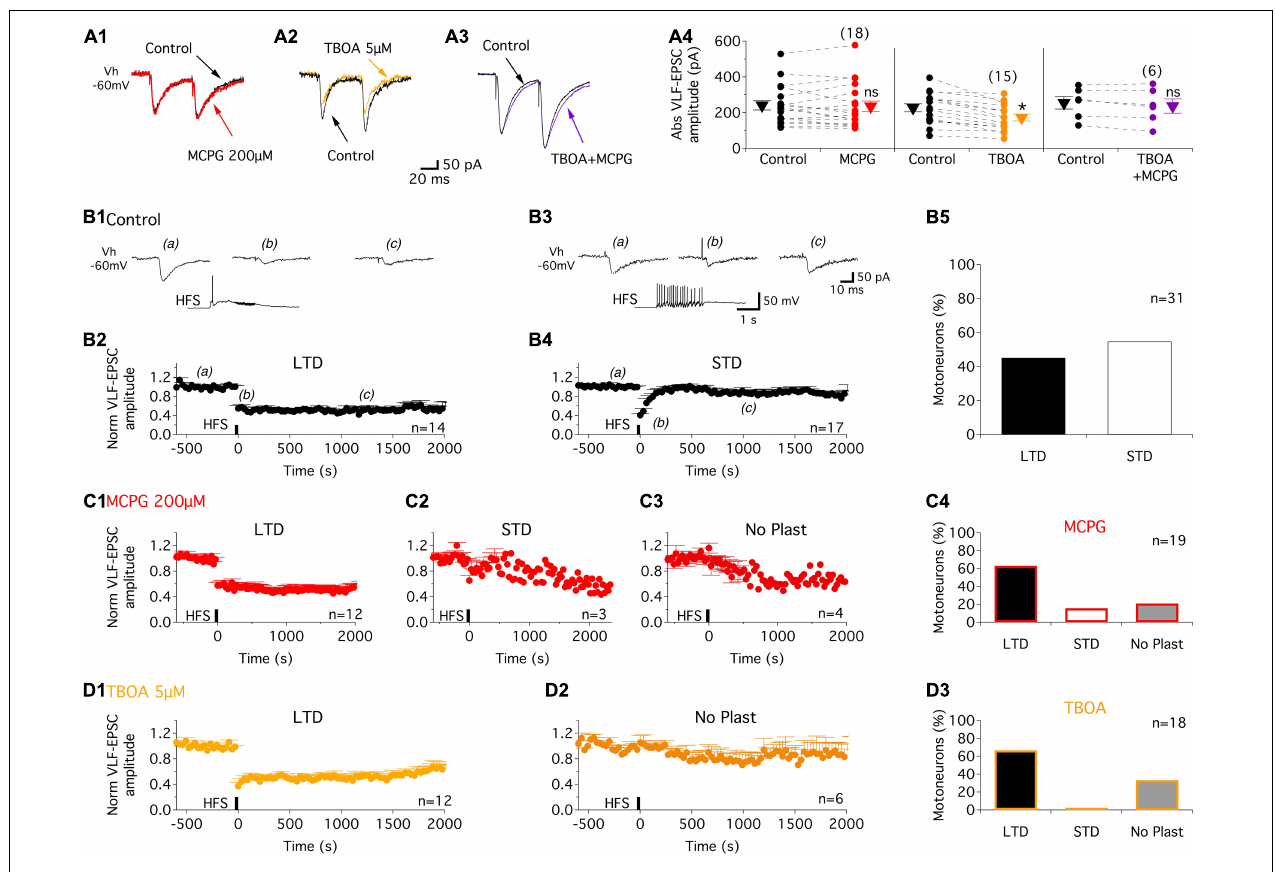
FIGURE 1 | Increased glutamatergic release activates mGluR receptors and contributes to activity-dependent synaptic plasticity (ADSP) expressed at VLF-MN synapses. (A) Representative traces of EPSCs triggered by paired stimulations (50 ms interval) applied to VLF axons in lumbar MNs held at –60 mV (Vh –60 mV) in P1-P3 mice in control condition (black traces) and in the presence of the broad-spectrum antagonist, MCPG, (red trace, A1 ), the glutamate transporter inhibitor, TBOA, (orange trace, A2 ) and MCPG + TBOA (purple trace, A3 ). (A4) Note that the depressing effect of TBOA on VLF-EPSC amplitudes was suppressed in the presence of MCPG. Scatter plots with connecting lines (dashed) of the absolute EPSC amplitude values (Abs VLF-EPSC) in the different experimental conditions. ns: non-significantly different, Wilcoxon test, p = 0.6 for MCPG and p = 0.1 for TBOA + MCPG. *Significantly different, Wilcoxon test, p < 0.0001 for TBOA. The triangles correspond to means ± sem of the population tested in each condition and numbers in parentheses to the number of MNs tested. (B) Representative experiment illustrating VLF-HFS (50 Hz, 2 s)-induced LTD (B1,B2) and STD (B3,B4) in control condition in P1-P3 mice. Sample traces of VLF-EPSC before (a), at different time points after (b and c) and during VLF-HFS application (lower trace) in an LTD-expressing MN (B1) and a STD-expressing MN (B3) . (B2,B4) Pooled data showing average time courses of normalized VLF-EPSC amplitudes in MN expressing LTD (B2) or STD (B4) in control condition in P1-P3 mice. (B5) Percentage of MNs expressing the different types of ADSP. (C) Pooled data for LTD (C1) and STD (C2) time courses or an absence of synaptic plasticity (No Plast, C3 ) after VLF-HFS in the presence of MCPG. (C4) Histogram of MN repartition according of ADSP expressed following VLF-HFS. (D) Same as in (C) but in the presence of TBOA. Note the absence of STD induction. n , number of MNs.